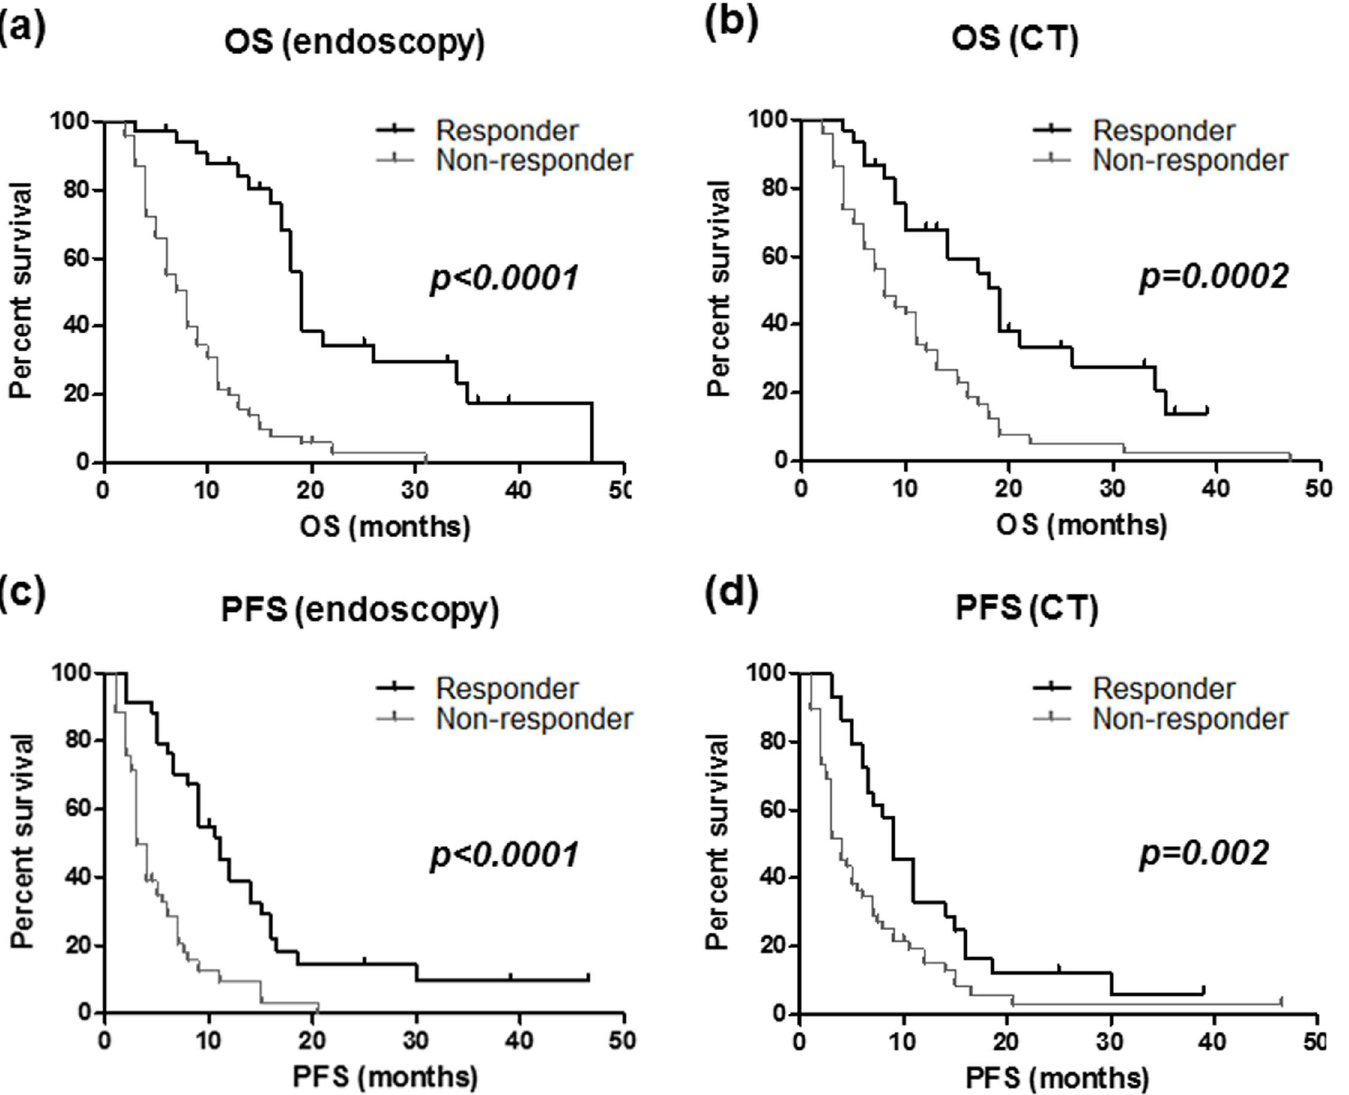
Fig 5. Overall survival (OS, upper) and progression-free survival (PFS, lower) and endoscopy (left) and CT (right) based response evaluations in stage IV cases that have peritoneal dissemination or distant metastasis. Different two groups was assessedusing the Kaplan-Meier method and the Log rank